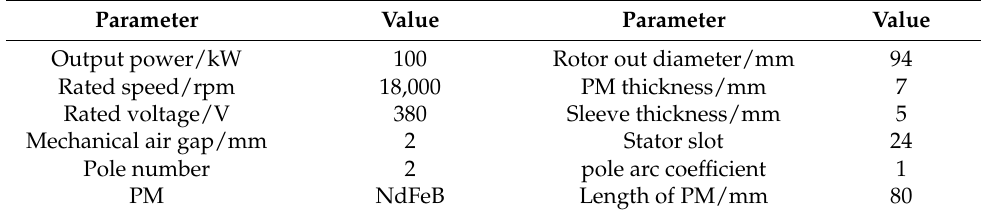
Table 1. Main parameters of HSPMM.